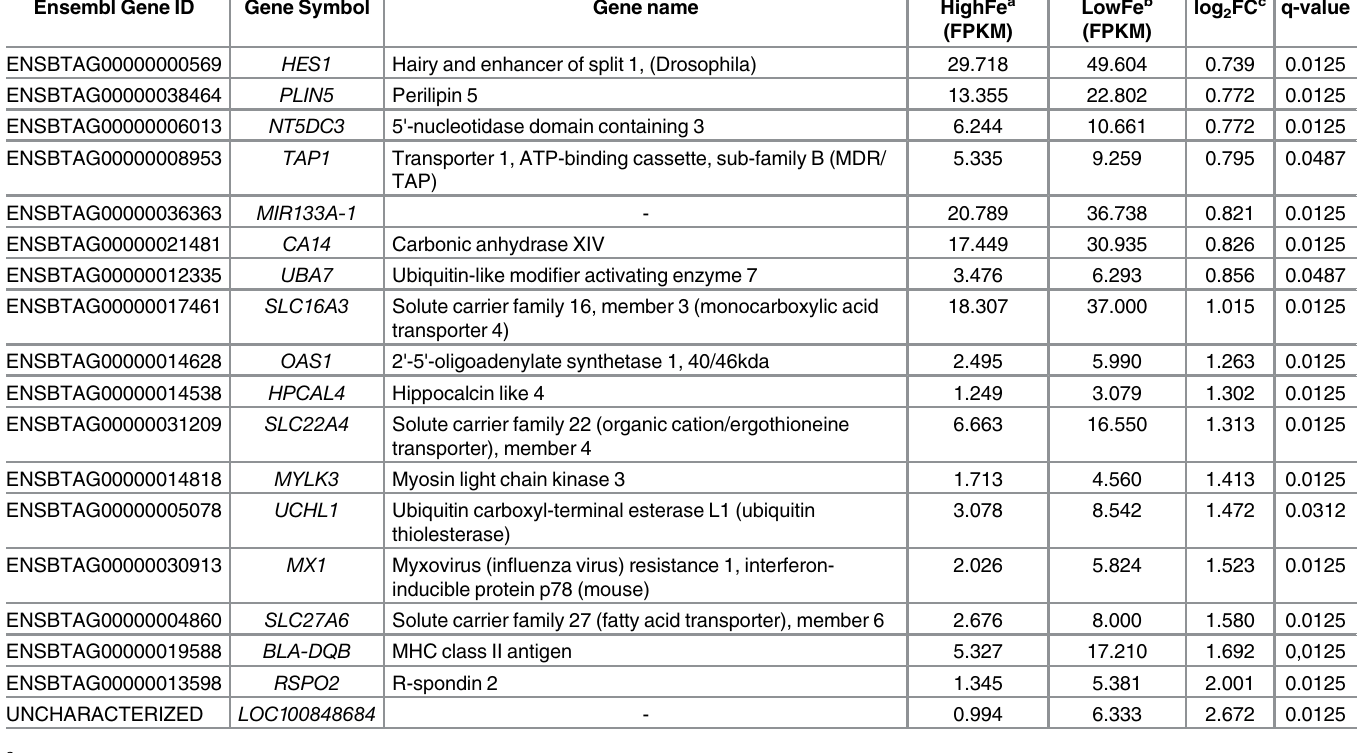
Table 2. Significantly up-regulated genes identified in the Nelore steers Longissimus dorsi muscle with low genomic estimated breeding value compared to animals with high genomic breeding value for iron content. Ensembl Gene ID Gene Symbol Gene